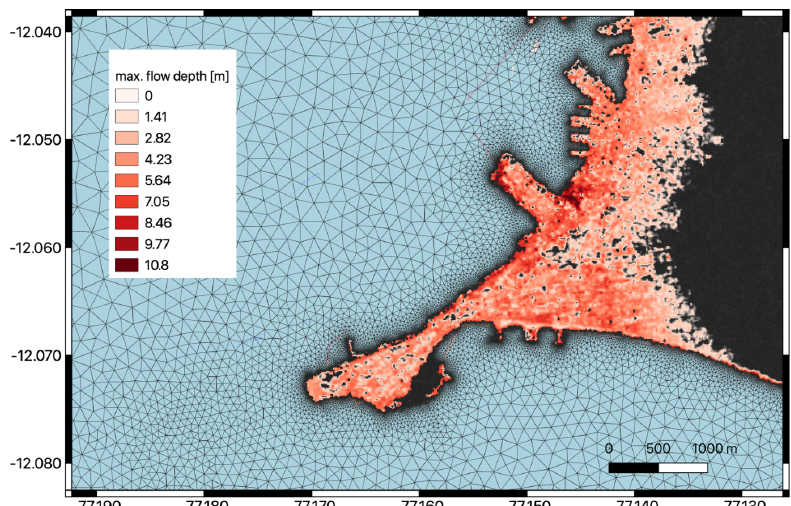
Figure 3. Section of the triangular mesh together with the inundation data product (10m raster) for the tsunami scenario involving a mag- nitude 8.8 event in the Callao harbour area. The basemap is from © OpenStreetMap contributors 2021. Distributed under the Open Data Commons Open Database License (ODbL)